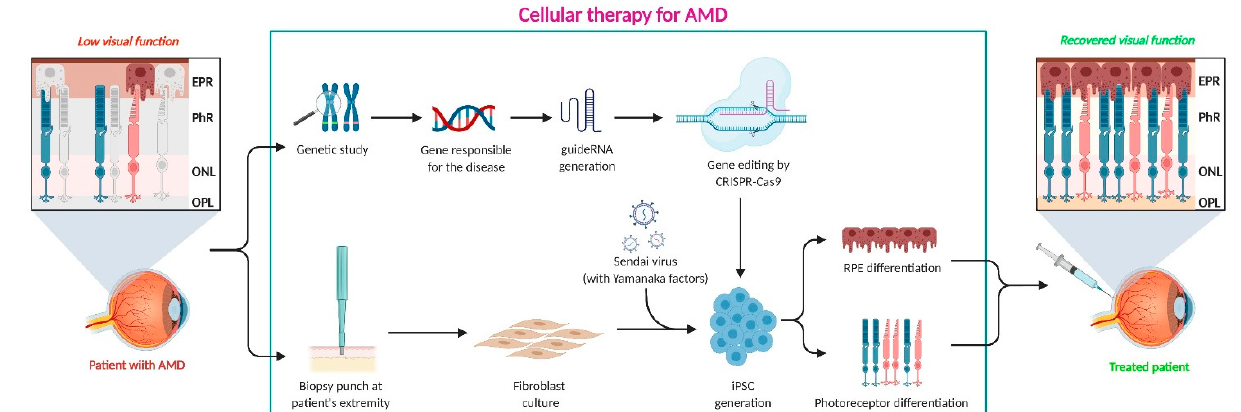
Figure 4. Cell therapy strategies for neovascular AMD.